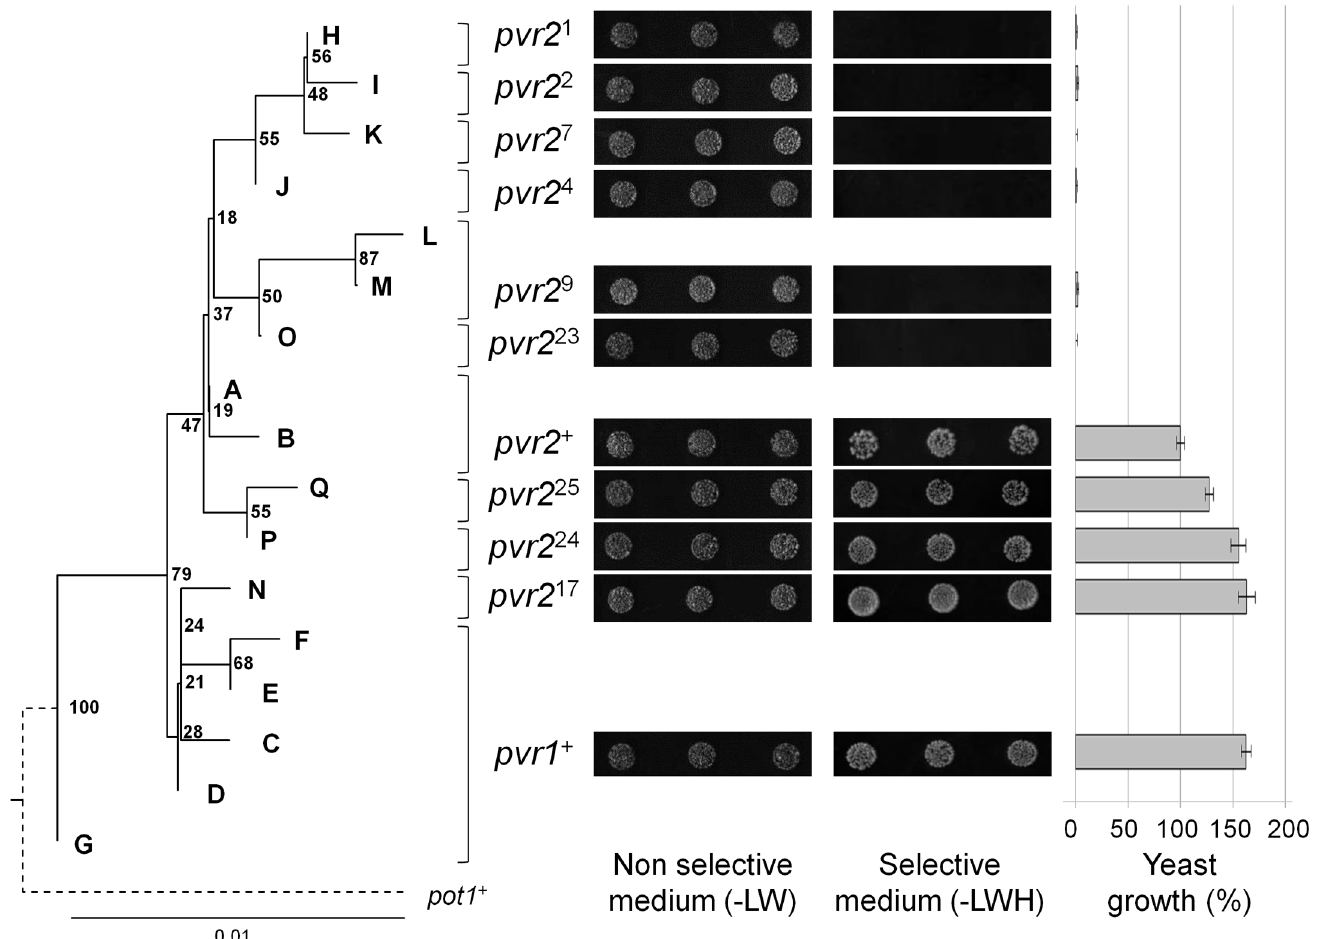
Fig 4. Phylogeny of pvr2/eIF4E1 nucleotide sequence haplotypes and pvr2/eIF4E1-VPg:PVY interactions. The presented phylogeny was reconstructed by the NJ method using pvr2/eIF4E1 , coding sequences. Bootstrap values (1000 replicates) are indicated on the nodes. A to Q are pvr2/ eIF4E1 haplotypes identified in chiltepin populations pvr1 + and pvr2 + to pvr2 25 denote pvr2/eIF4E1 alleles deduced from the pvr2/eIF4E1 coding sequences; pot1 + : Potyvirus susceptibility allele from tomato ( Solanum lycopersicum , accession number AY723733). pvr2/eIF4E1-VPg:PVY interactions were evaluated by yeast two-hybrid assays. Yeast growth (%) indicates the percentage of the yeast growth on the selective medium (-LWH) compared to the reference yeast colonies co-transformed with pGADT7:: pvr2 + and pGBKT7::VPg-PVY; standard errors were obtained after 3 replicates of the yeast two-hybrid assays in which 3 independent colonies for each pvr2/eIF4E1-VPg:PVY combination were randomly